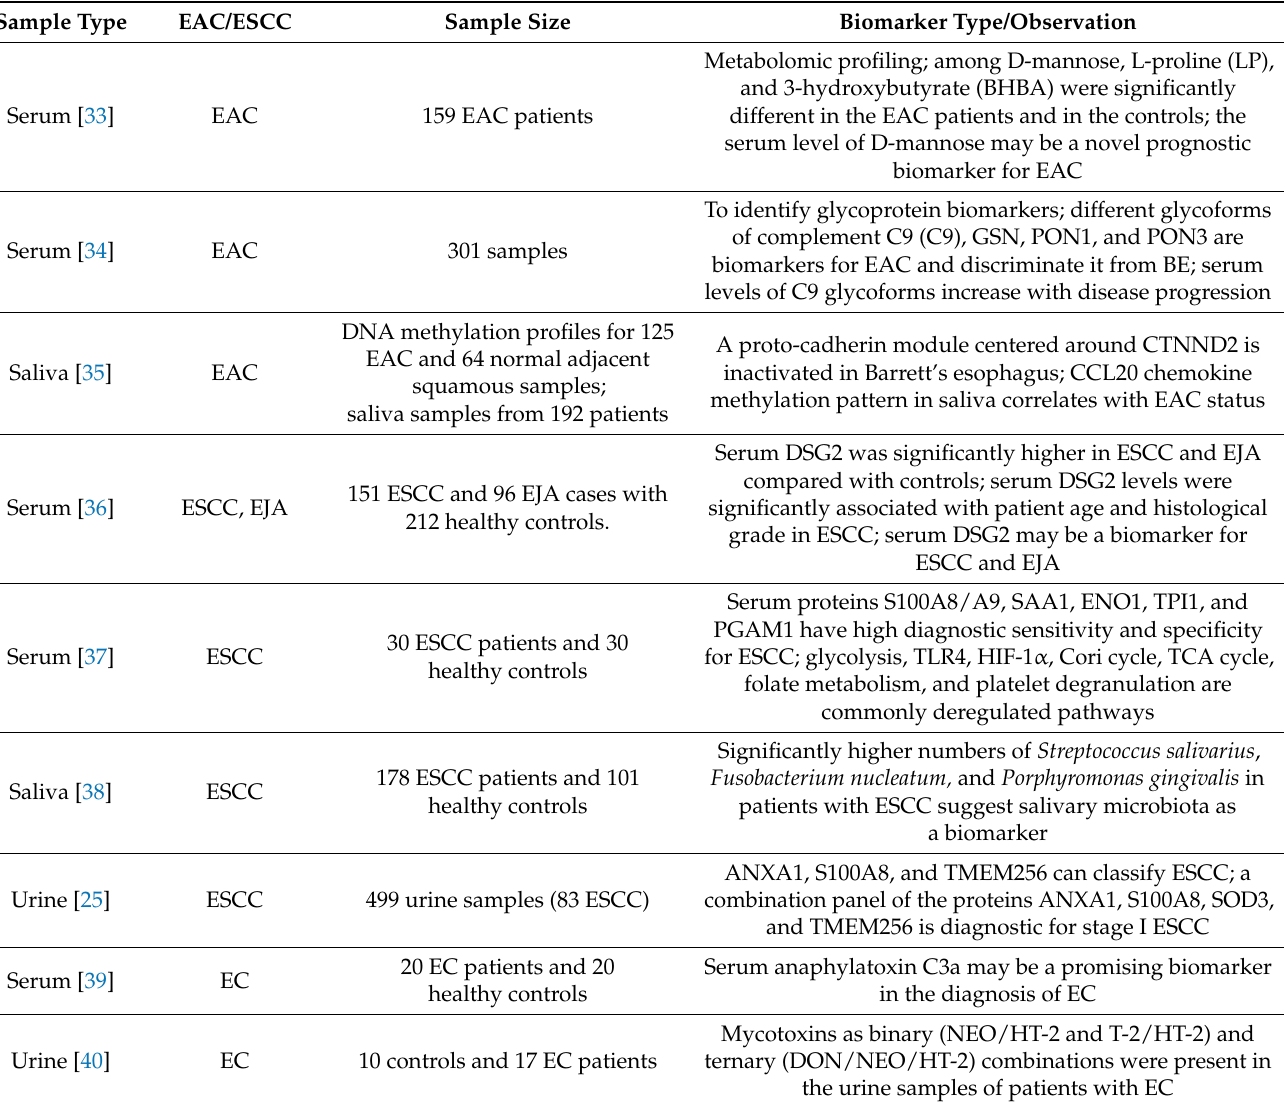
Table 1. Non-invasive biomarkers for esophageal carcinoma. Esophageal squamous cell carcinoma (ESCC), esophageal adenocarcinoma (EAC), gelsolin (GSN), serum paraoxonase/arylesterase 1 (PON1) and serum paraoxonase/lactonase 3 (PON3), desmoglein-2 (DSG2), serum amyloid